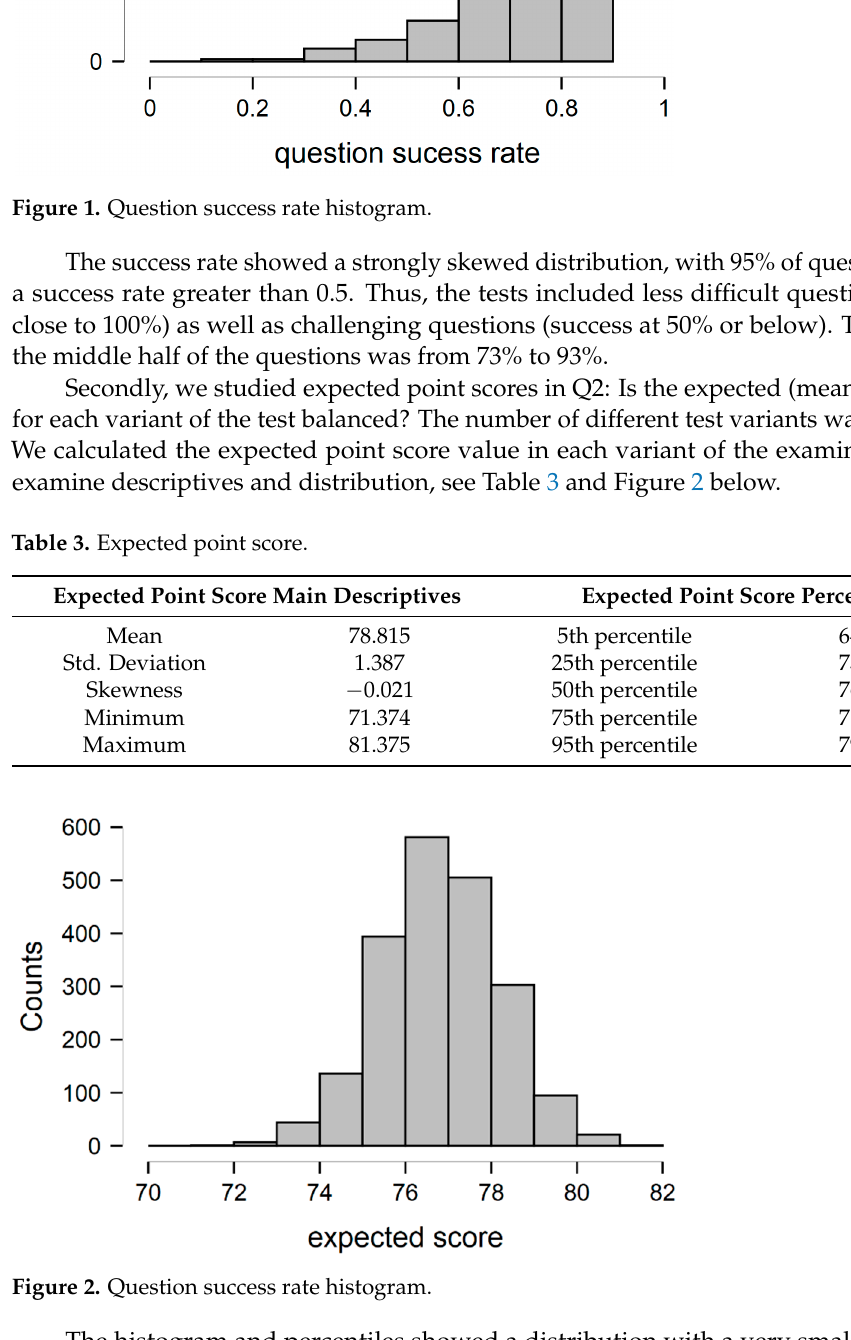
Table 2. The success rate of questions.